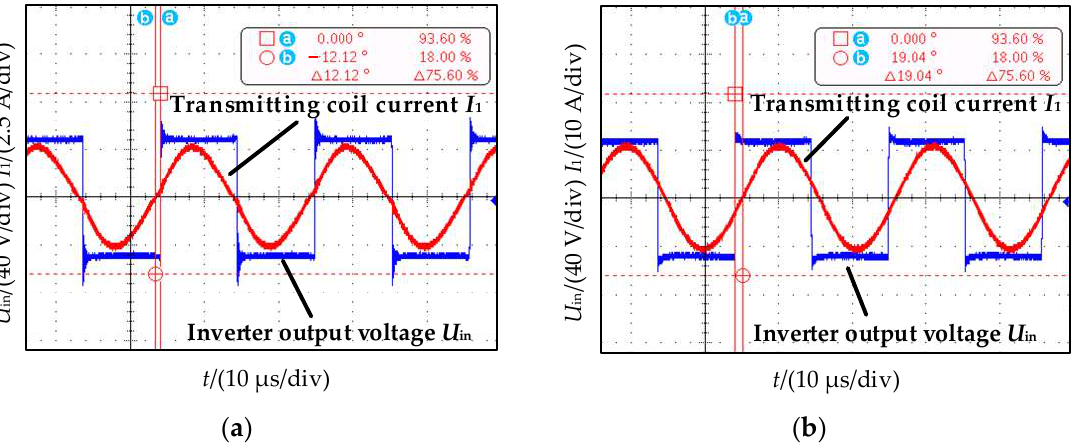
Figure 13. The coil distance is 24 cm, the voltage and current phase diagram of the transmitter: ( a ) R L = 5 Ω; ( b ) R L = 15 Ω.